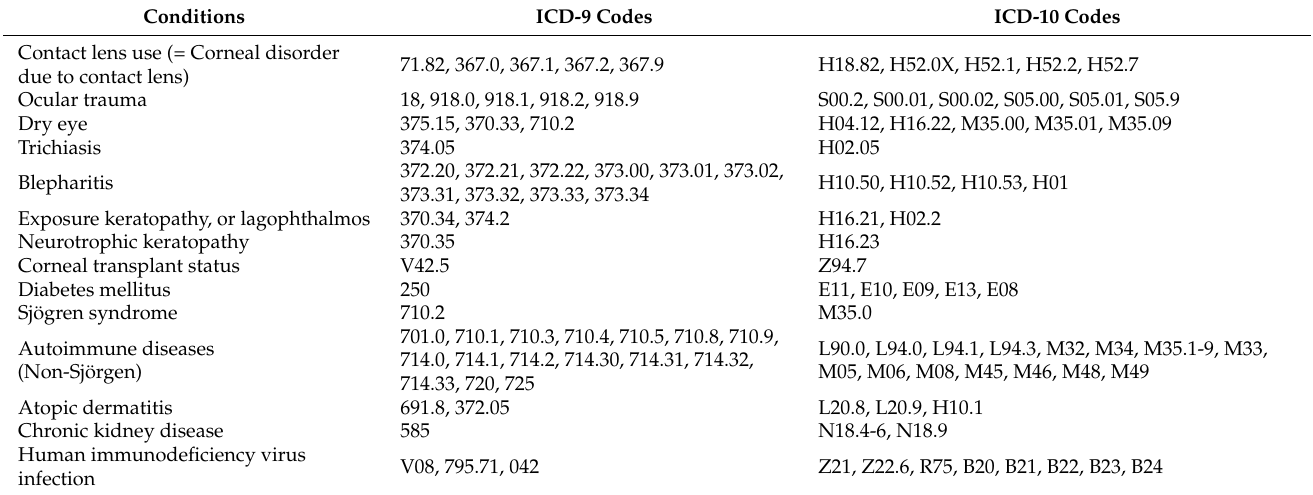
Table A1. International Classification of Diseases, 9th Revision, Clinical Modification codes